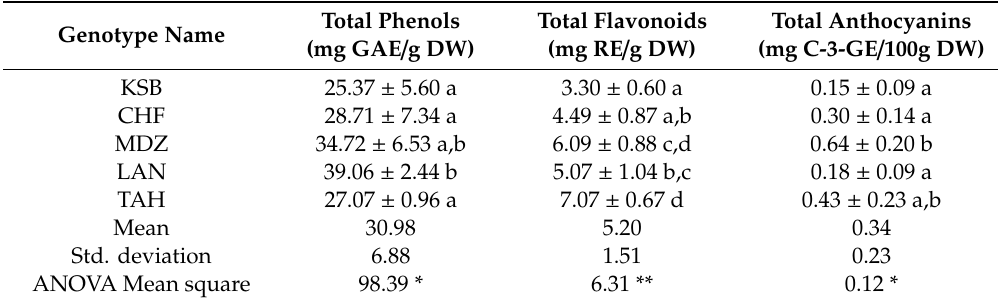
Table 4. Phytochemical composition (total phenols, total flavonoids, total anthocyanins) in fruits of strawberry tree